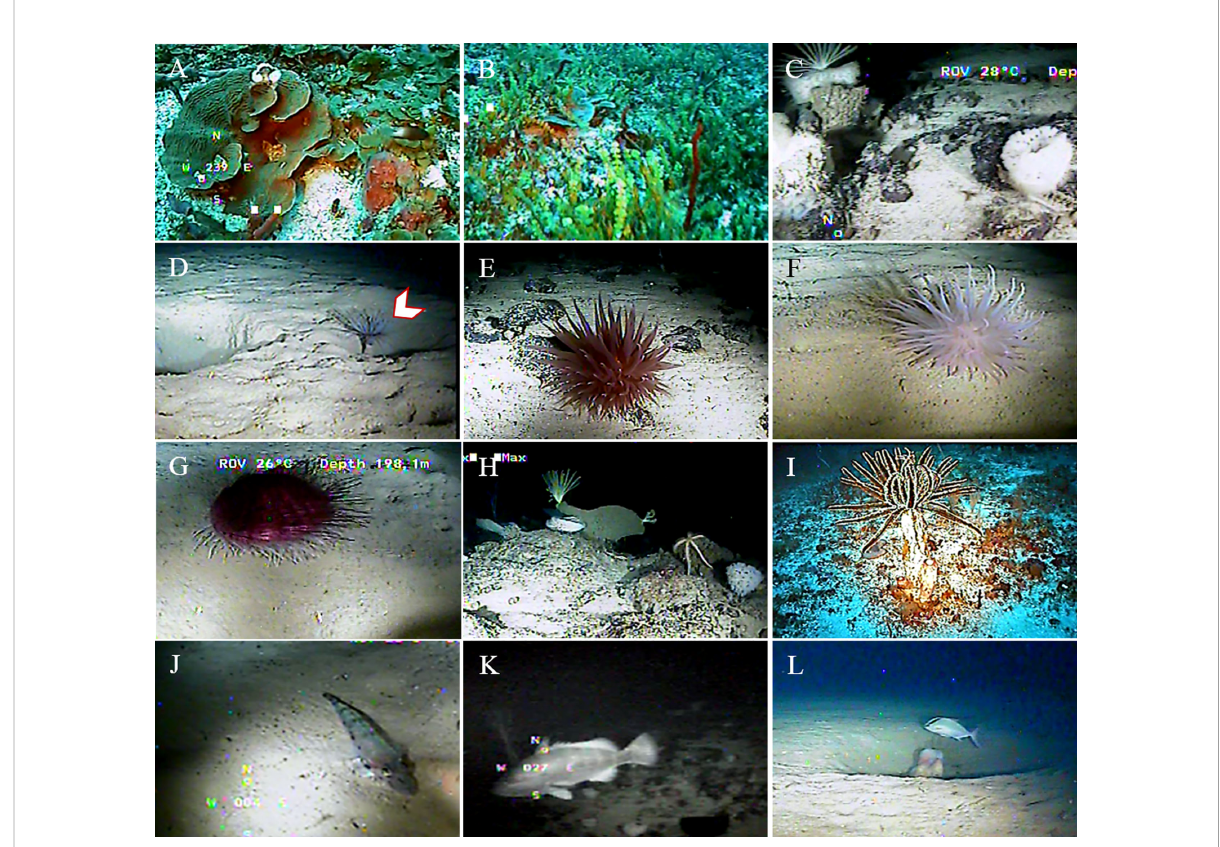
FIGURE 3 Example of the fauna found in the Corales de Profundidad National Natural Park (CPNNP). (A) Agaricia sp.; Lobophora variegata and Stegastes partitus . (B) Halimeda copiosa . (C) Glass sponges and Comatulida spp. 2. (D) Ceriantheopsis sp. (E, F) Liponema spp. (G) Araeosoma cf. fenestratum . (H) Comatulida spp. 2 and Ophiacanthida sp. (I) Nemaster grandis . (J) Percophidae, Bembrops sp. (K) Epinephelus sp. (L) Seriola